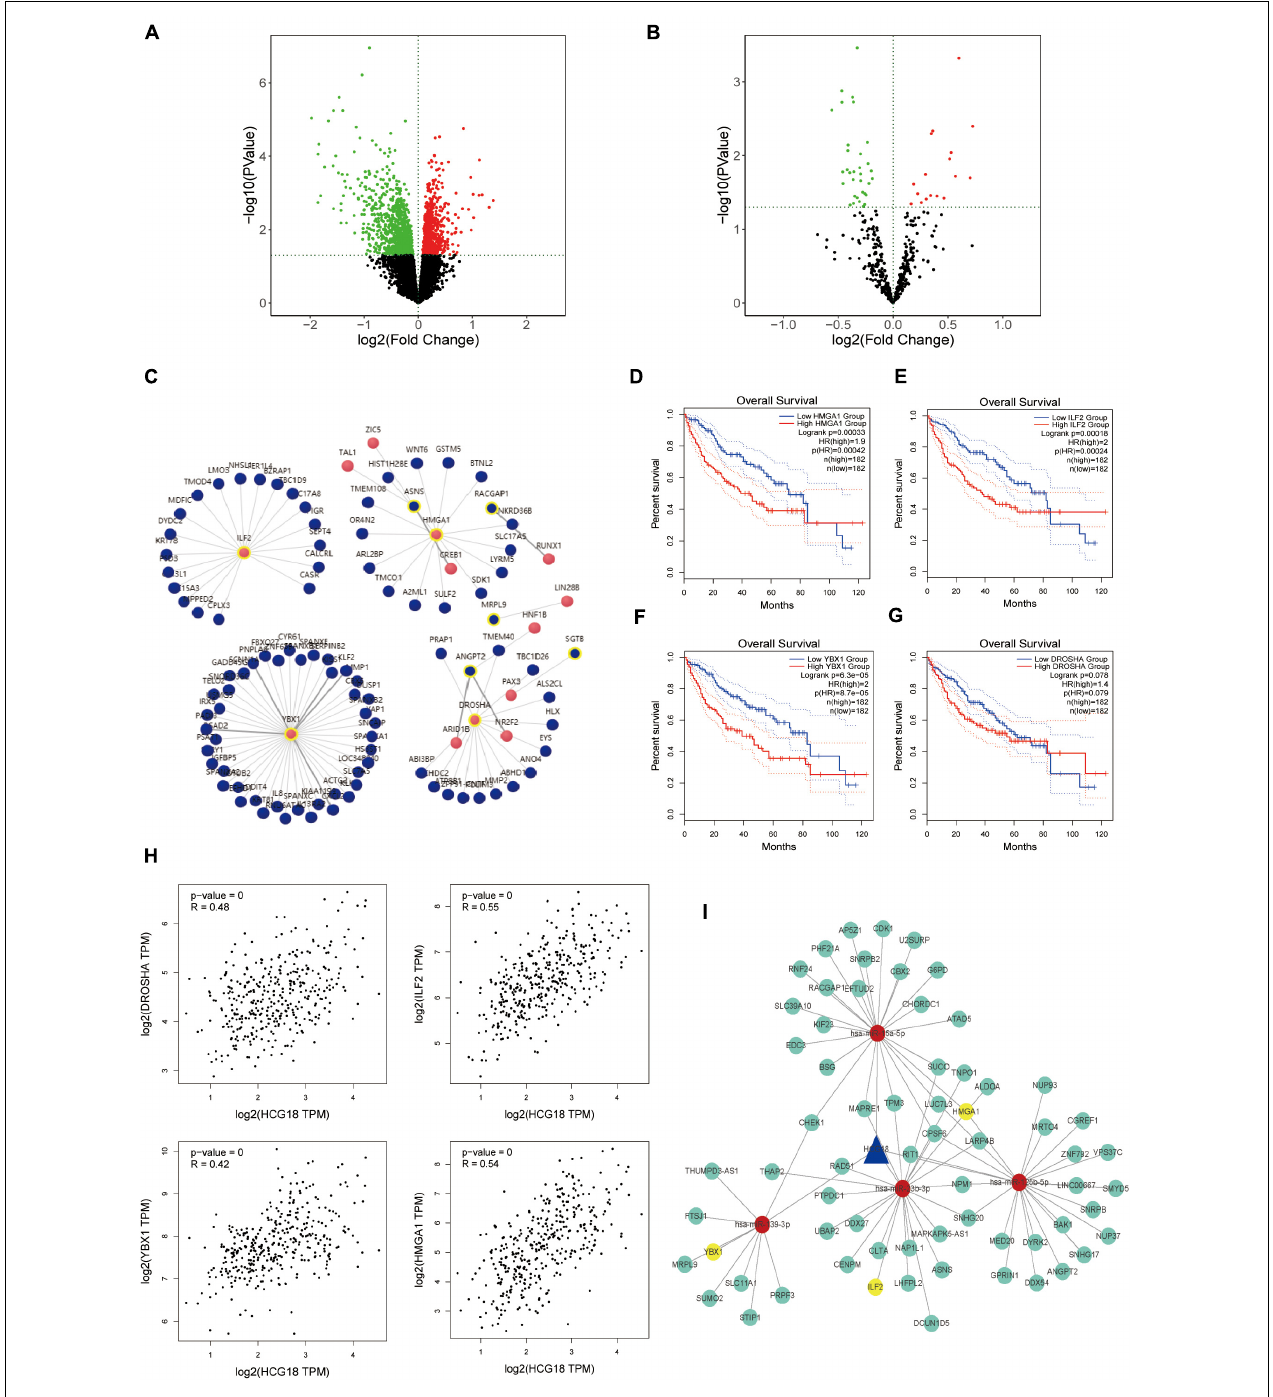
FIGURE 2 | HCG18 is the core lncRNA for vascular invasion in hepatocellular carcinoma. (A) Volcanic map of transcriptome differential expression based on vascular infiltration (RNASeq); P < 0.05 was the standard for screening genes. Green represents low expression of vascular versus non-vascular invasion genes, and red represents high expression. (B) Volcanic map of differentially expressed transcriptomes based on vascular invasion (miRNASeq). (C) Analysis of transcription factors where red represents transcription factors and yellow circles represent those involved in the core CE regulatory network. (D) Overall survival analysis of HMGA1. (E) Overall survival analysis diagram of ILF2. (F) Overall survival analysis diagram of YBX1. (G) Overall survival analysis diagram of DROSHA. (H) Scatter plot of HCG18 and expression levels of YBX1, ILF2, HMGA1, and DROSHA. (I) The core regulatory network involving transcription factors (YBX1, ILF2, and HMGA1) that regulate vascular invasion. Yellow represents transcription factors, red represents miRNA, and blue represents lncRNA. All three transcription factors are regulated by HCG18.